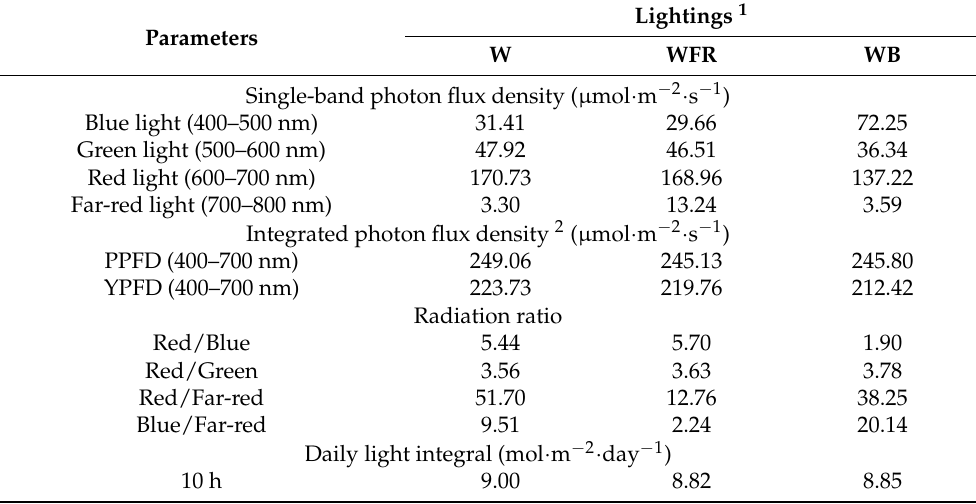
Table 1. Spectral data for the light-emitting diodes (LEDs).